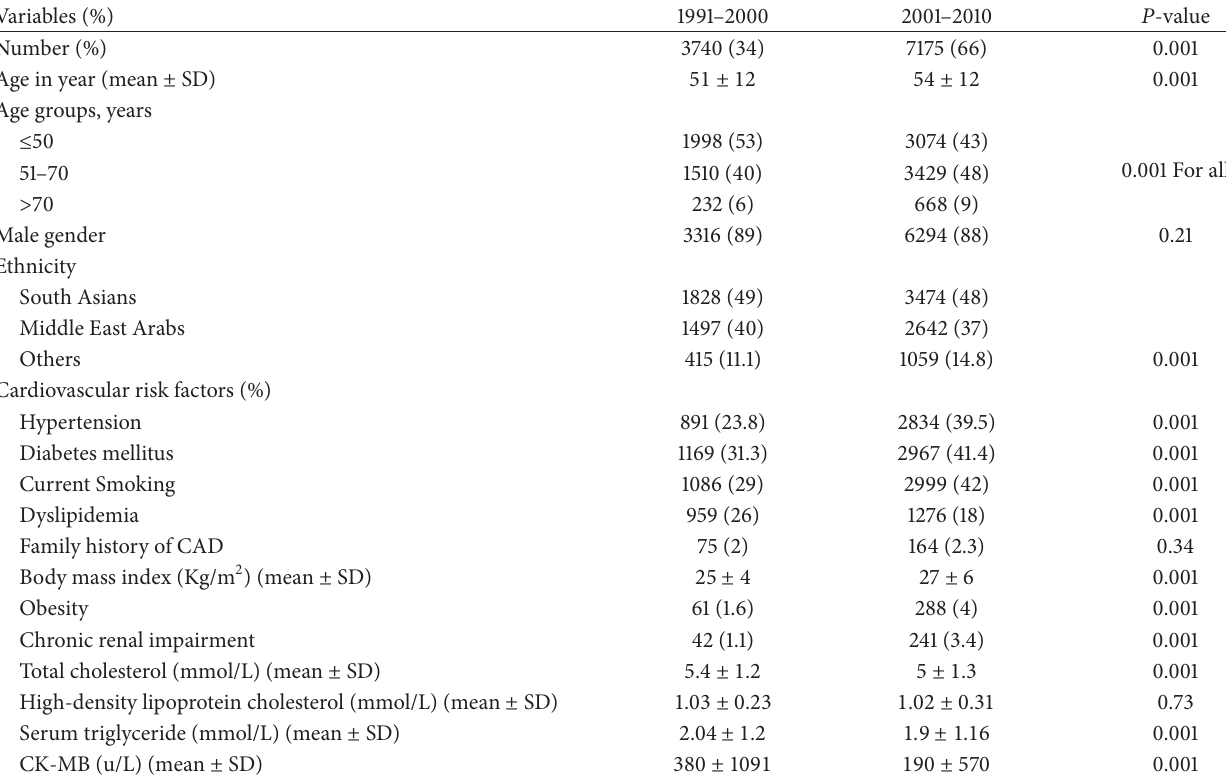
Table 1: Patients characteristics according to study period